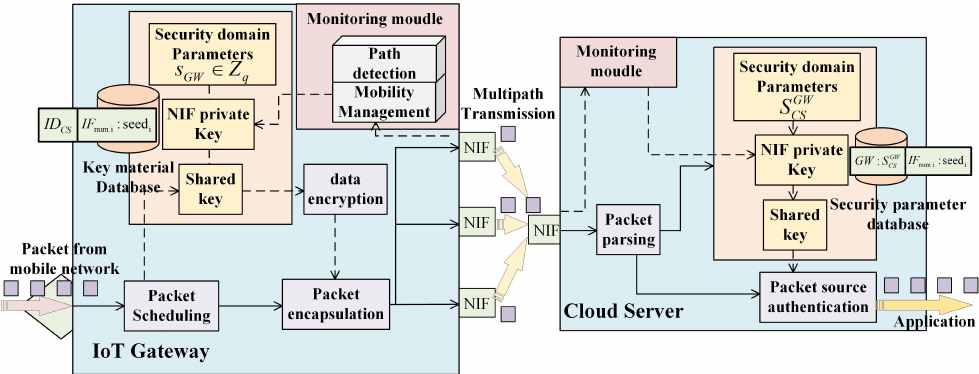
Figure 9. Function module design of the GW and CS in the communication process, presenting the processes of context monitoring, key generation, and data